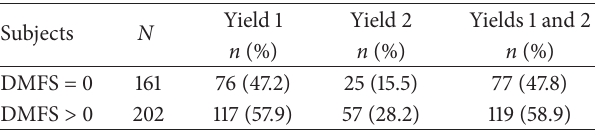
Table 3: The number and proportion of subjects with yield from the radiographic examination in relation to the clinical